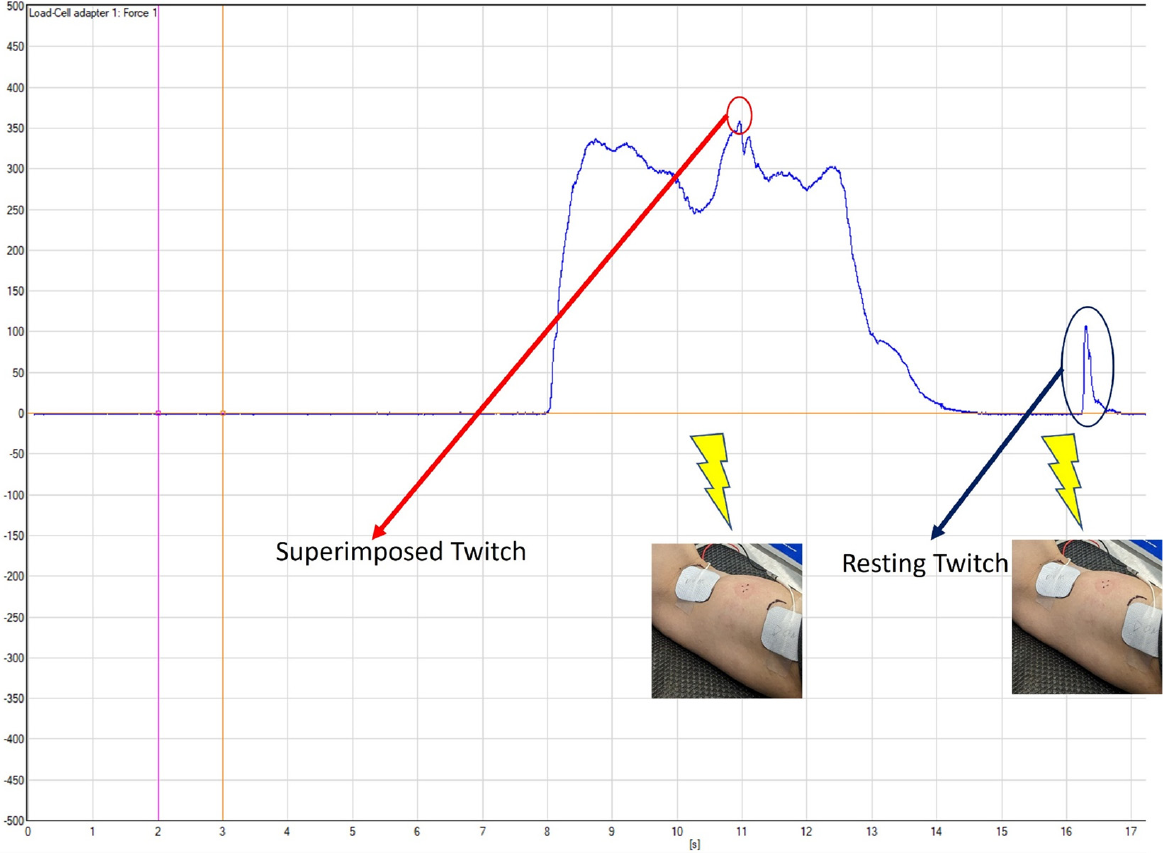
Figure 2. The time-varying force curve from a representative subject’s maximal isometric contraction with the twitch interpolation.